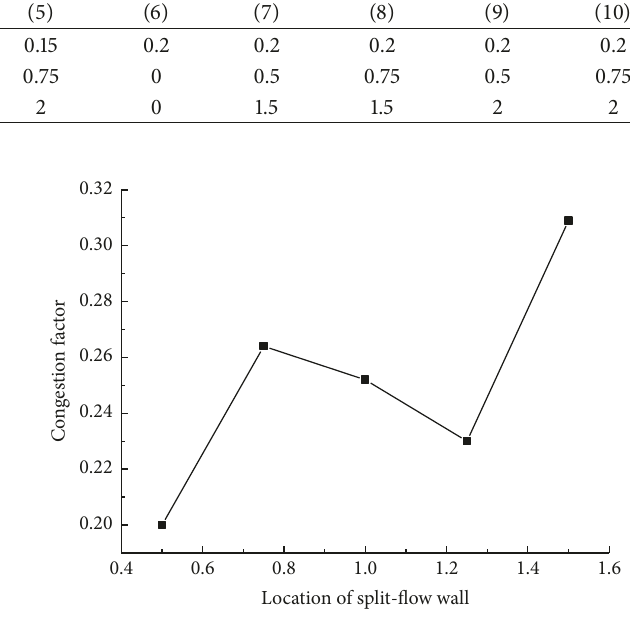
Figure 11: Congestion factor when 𝐿 = 1.5 , 𝜌 = 0.3 .